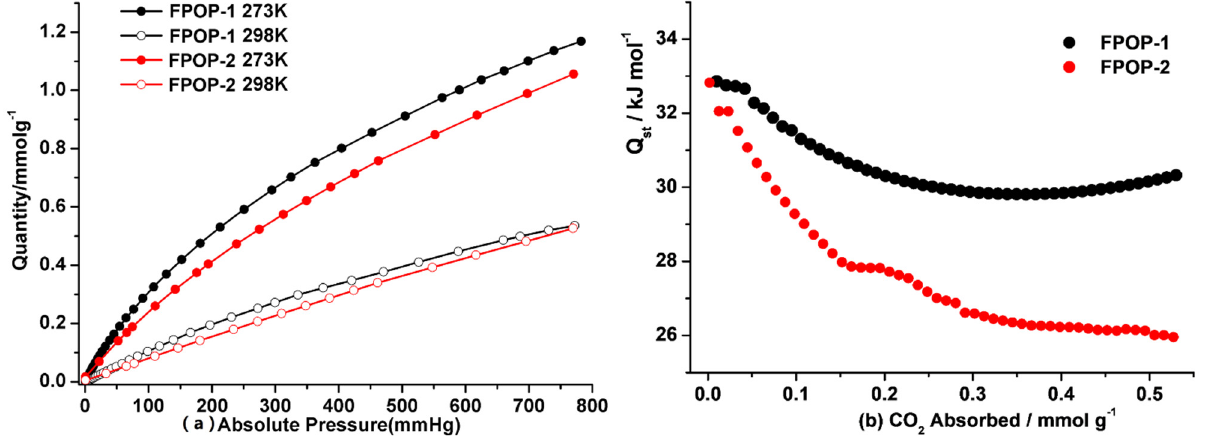
Figure 7. CO 2 adsorption isotherms of FPOP-1 and FPOP-2 at 273 and 298K ( a ); isosteric heat of CO 2 adsorption of FPOP-1 and FPOP-2 ( b ).